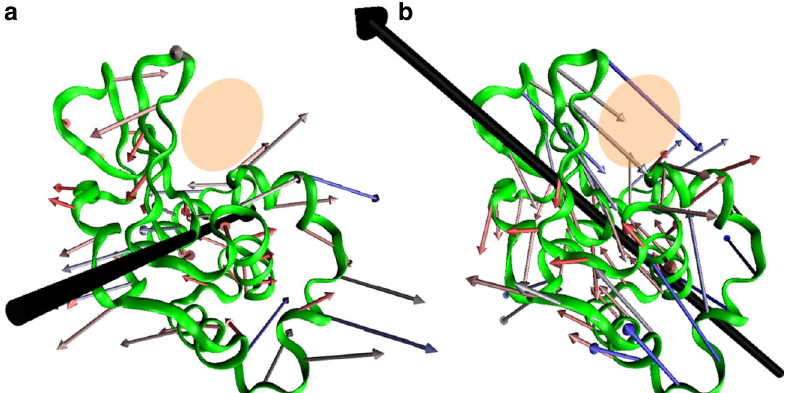
Fig. 1 Directionality of global intramolecular vibrations. The vector diagrams of two calculated low frequency vibrations for CEWL at ( a ) 12.3 cm − 1 (0.37 THz) and b 11.6 cm − 1 (0.35 THz). The orange shaded region highlights the binding region. While the two vibrations nearly overlap in energy, their motions are dramatically different. For the 12.3 cm − 1 case the largest amplitude motion is largely out of the page, with little motion around the binding site, whereas the 11.3 cm − 1 vibration moves in the page with a large compressive motion into the binding region. The black arrows indicate the light polarization direction needed to excite the vibration, demonstrating that polarization dependent absorption measurements on aligned samples readily discriminates